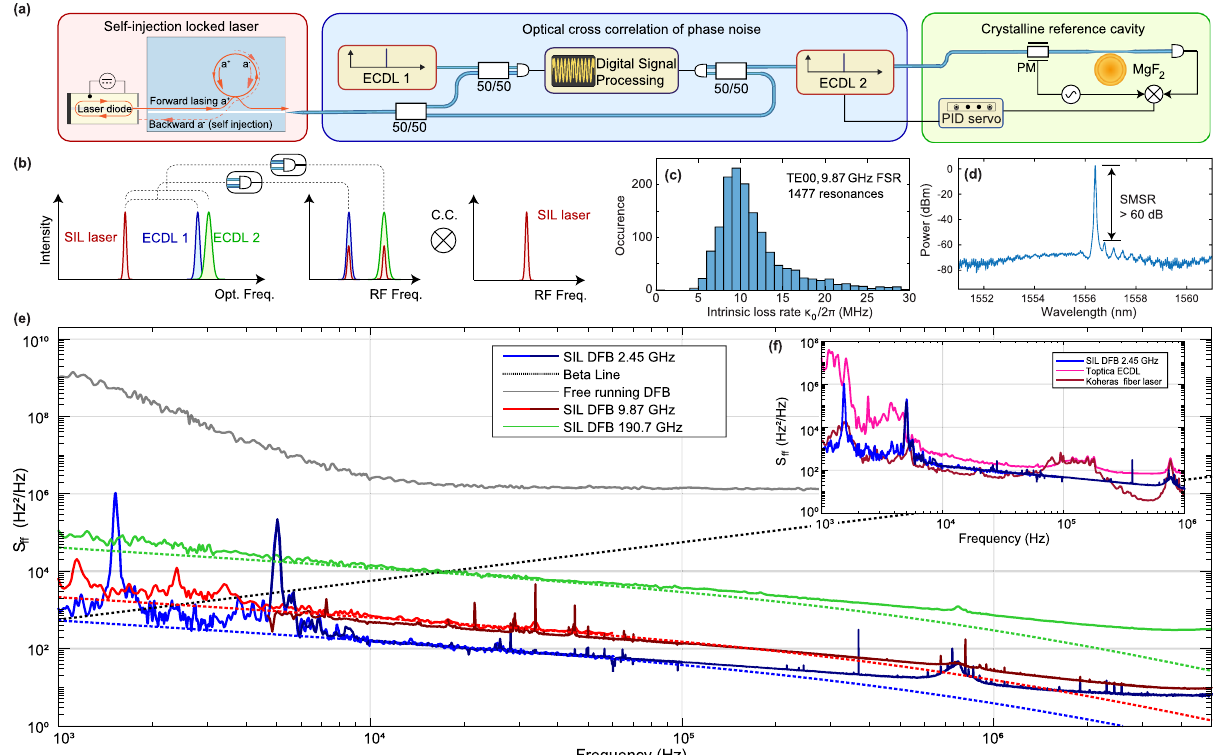
Fig. 2 Spectral purity of the self-injection-locked laser. a Experimental schemes of laser frequency noise measurements, using optical cross-correlation technique or heterodyne beat with the external cavity diode laser (ECDL) locked to a high- Q crystalline resonator using the Pound-Drever-Hall technique. b Schematic in the frequency domain of optical cross-correlation (C.C.) technique. c The Si 3 N 4 photonic chips with an FSR of 9.87 GHz have an intrinsic loss of κ 0 /2 π < 10 MHz, corresponding to a quality factor of Q 0 > 20 × 10 6 . The κ 0 /2 π histogram of 1477 TE 00 resonances from a 9.87 GHz FSR microresonator is shown. d Optical spectrum of the SIL DFB emission. e Single-sided PSD of frequency noise of the hybrid integrated laser system upon self-injection locking to microresonators with FSRs: 190.7 GHz (green), 9.87 GHz (red), 2.45 GHz (blue) and free running regime (grey). Dark colour traces correspond to optical cross-correlation data, light colour traces to the heterodyne beat method. The dotted red, green, blue lines indicate the calculated thermo-refractive noise limit for Si 3 N 4 microresonators with different FSR. f The inset shows a comparison of frequency noise of SIL DFB with a commercial ECDL (Toptica CTL) and a commercial fi bre laser (NKT Koheras Adjustik